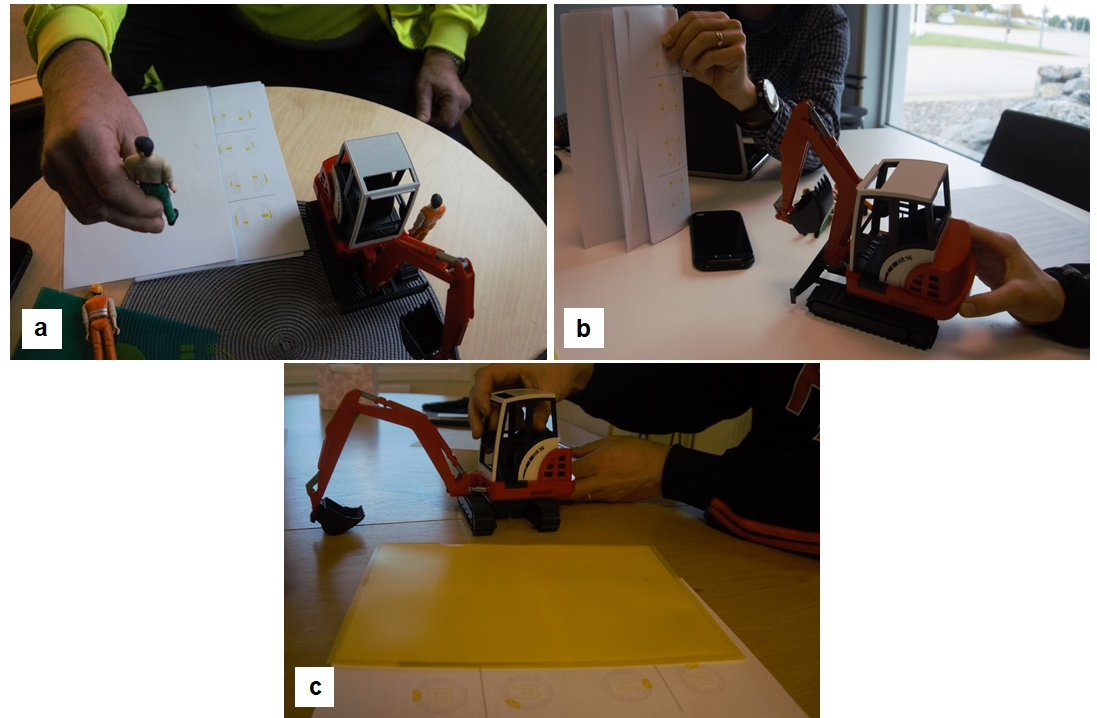
Figure 13. Some images that show how the evaluation was conducted. ( a ) The operators had to move the human toys to where the obstacle(s) is supposed to be based on the shown visualizations. ( b ) The operators had to tilt the excavator toy according to the shown visualizations to indicate the changing balance. ( c ) The operators rotated the undercarriage according to what is shown on the